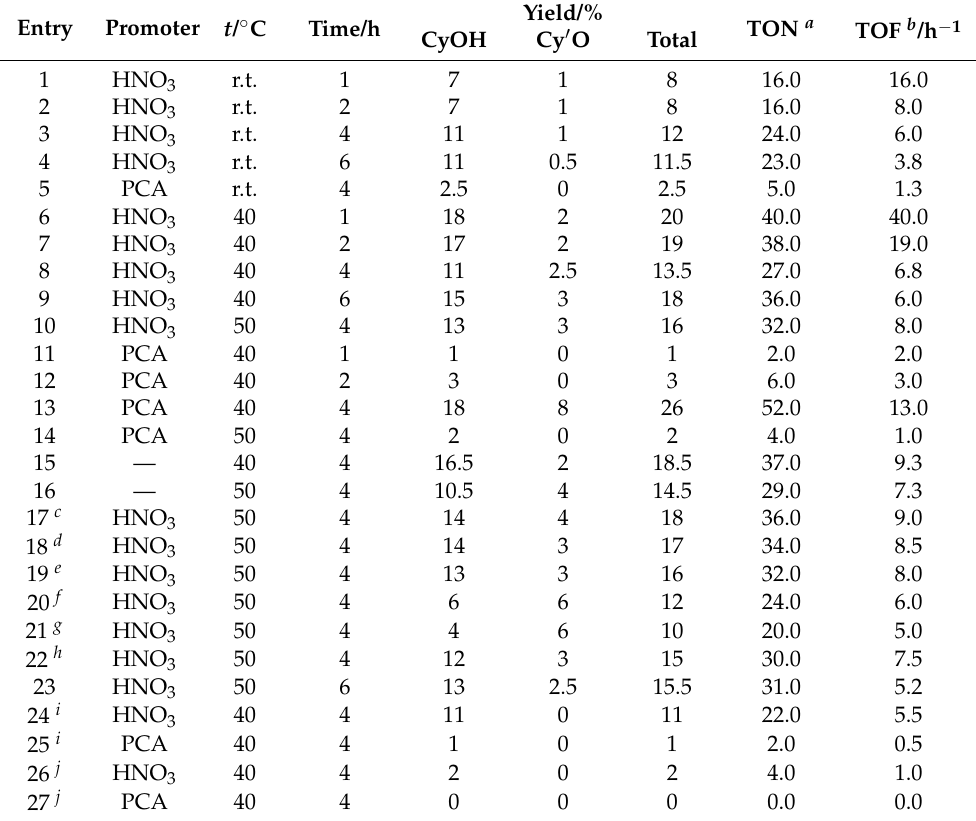
Table 1. Peroxidative oxidation of cyclohexane catalyzed by the tetranuclear Cu(II) complex 1 .